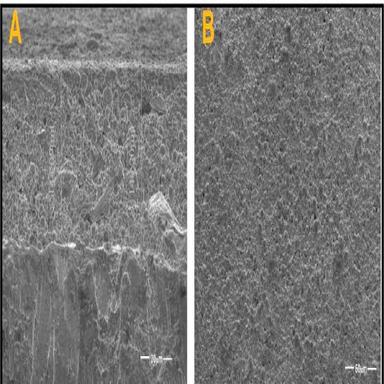
Thickness of the geopolymeric coating coated onto substrate and Morphology of advanced geopolymeric material over the surface.